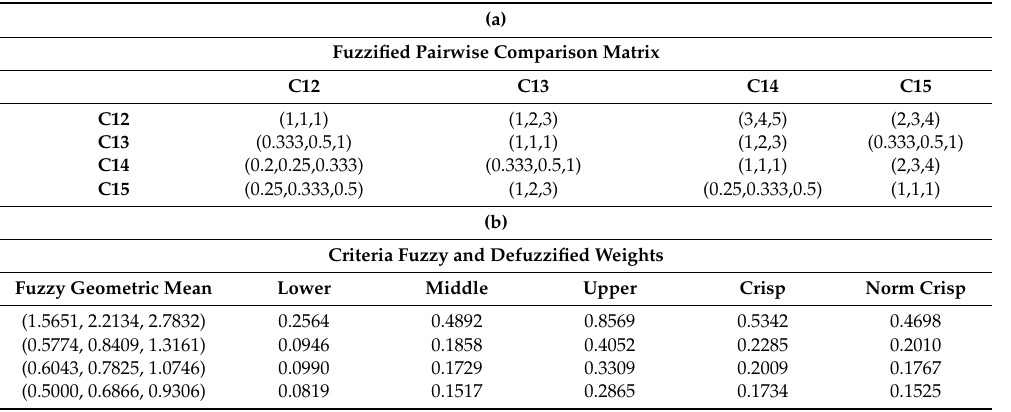
Table 8. SF-AHP results per criteria category for the category environmental. ( a ) Fuzzified pairwise comparison matrix; ( b ) Criteria fuzzy and defuzzified